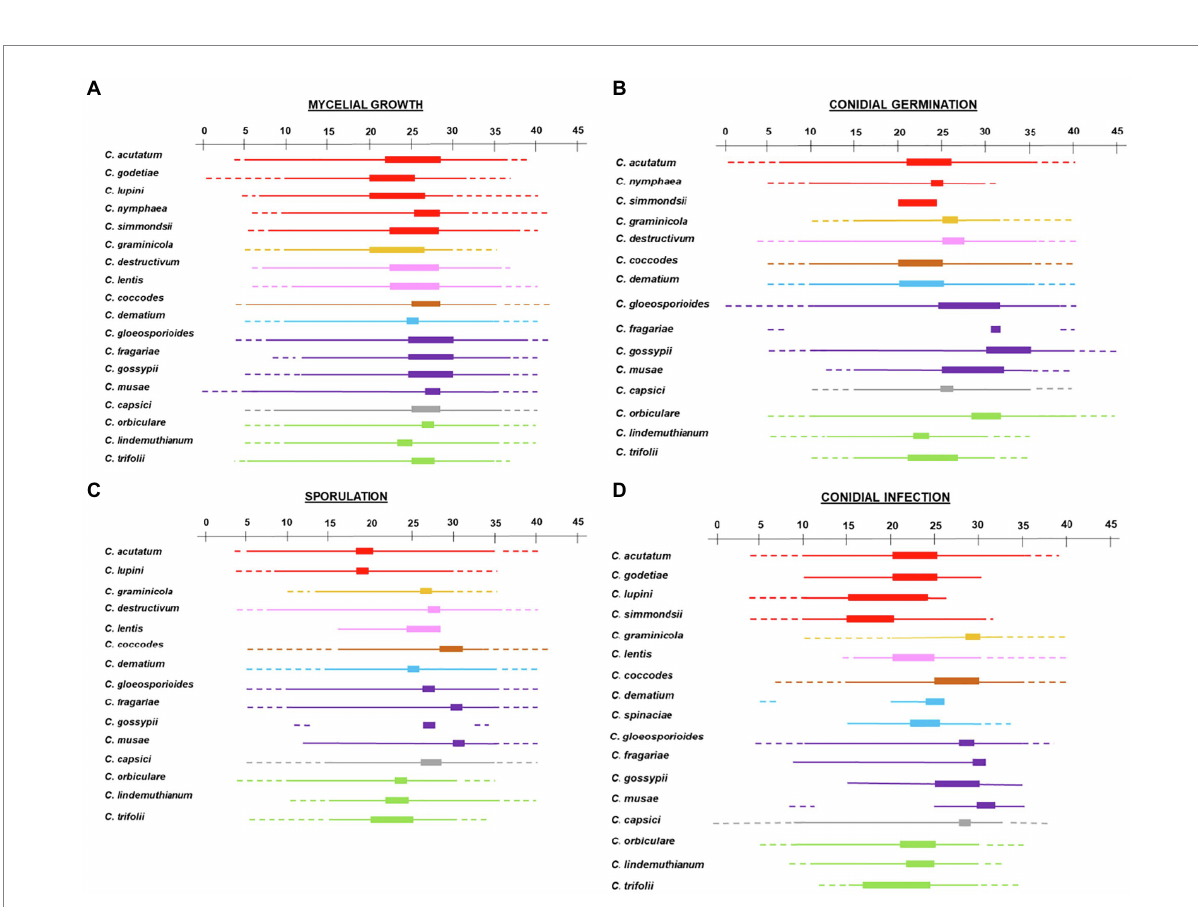
FIGURE 8 Temperature requirements of Colletotrichum spp. for (A) mycelial growth, (B) conidial germination, (C) sporulation, and (D) conidial infection. A temperature scale from 0 ° C to 45 ° C is indicated at the top of each panel. Thin lines indicate the temperature at which the different processes occur for each species. Thick lines indicate optimal temperatures. Dotted lines indicate temperatures that are known not to support the process based on experimental evidence. Clades are indicated by different colors: red is acutatum, orange is graminicola, pink is destructivum, brown is coccodes, blue is dematium, purple is gloeosporioides, gray is truncatum, and green is